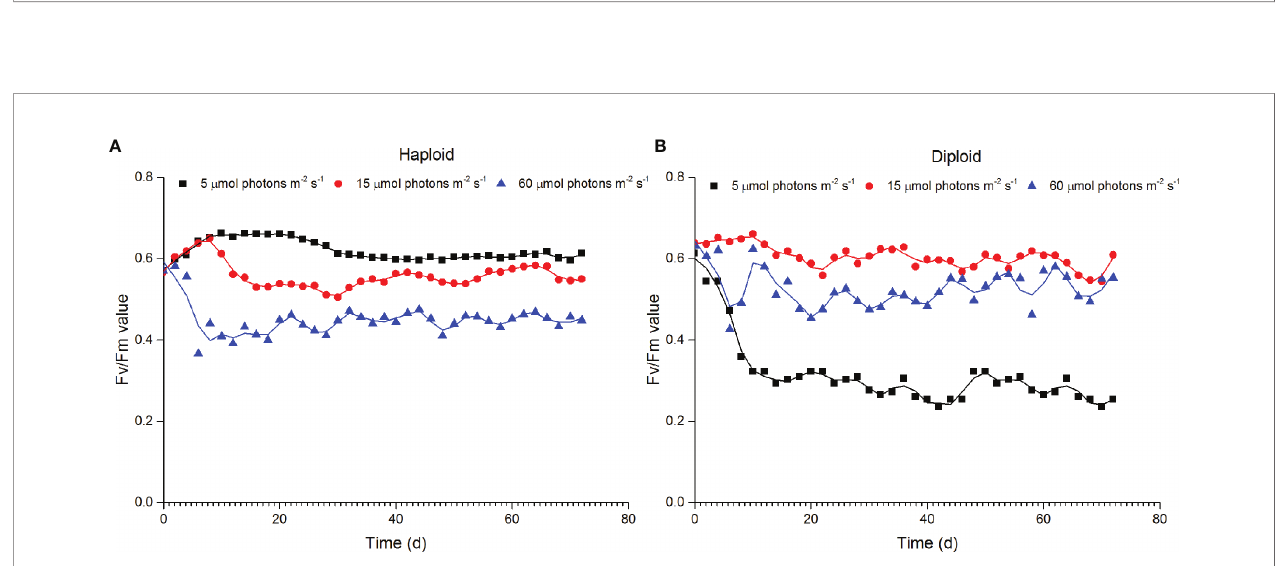
FIGURE 5 | Variations in the maximum PSII quantum yield (Fv/Fm) of haploid (A) and diploid solitary cells (B) of P. globosa under different light